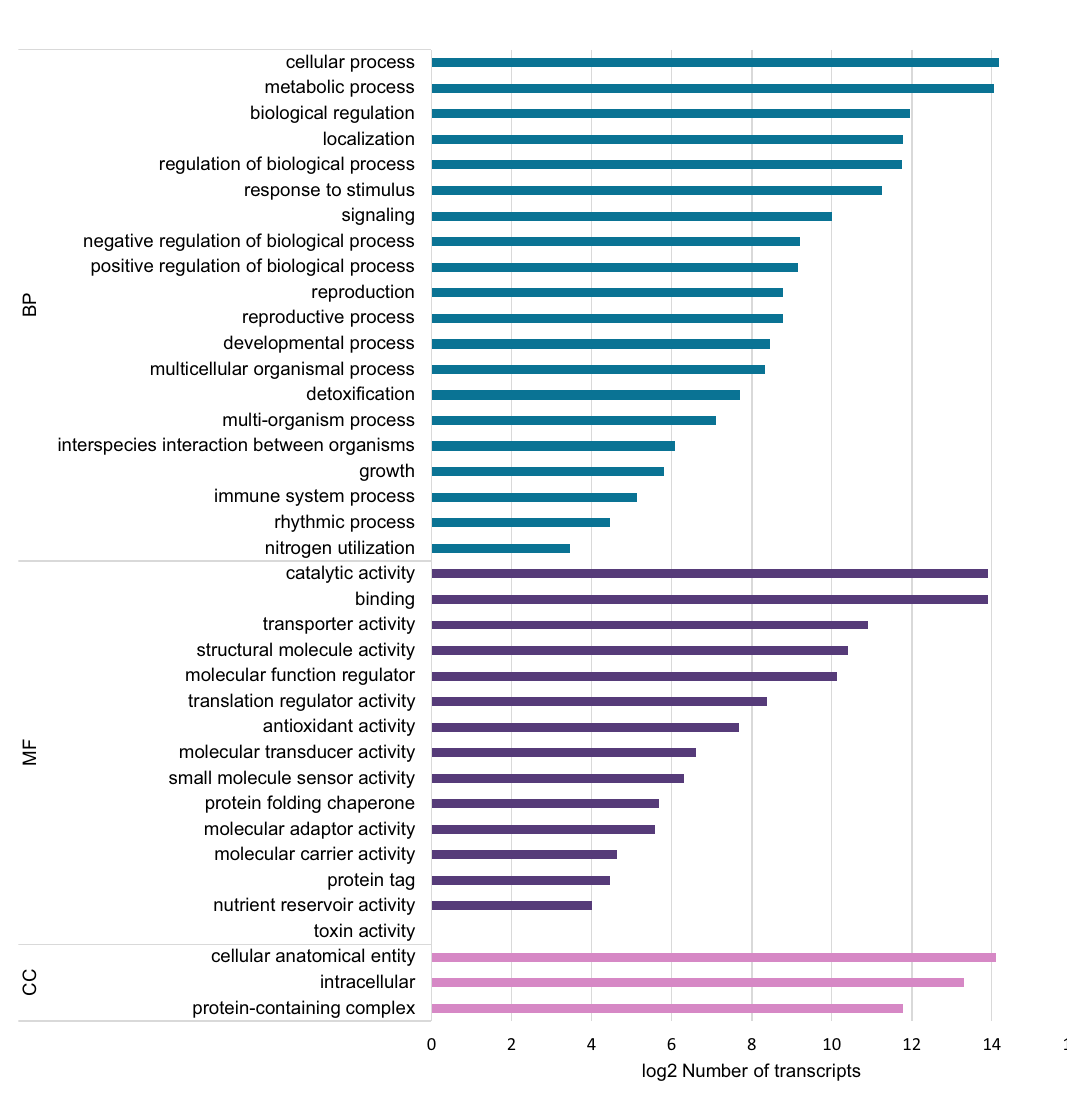
Figure 2. Gene Ontology (GO) analysis of RNA-seq. GO term classification of the entire transcriptome. BP biological process; CC cellular component; MF molecular